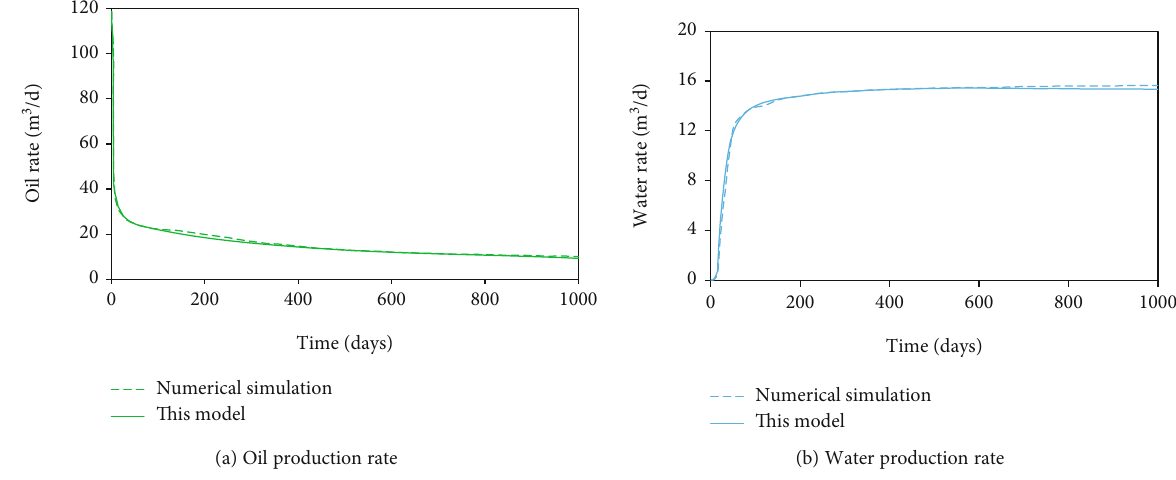
Figure 6: Comparison of the results of the numerical simulator and the semianalytical method. Table 2: Parameters used for sensitivity